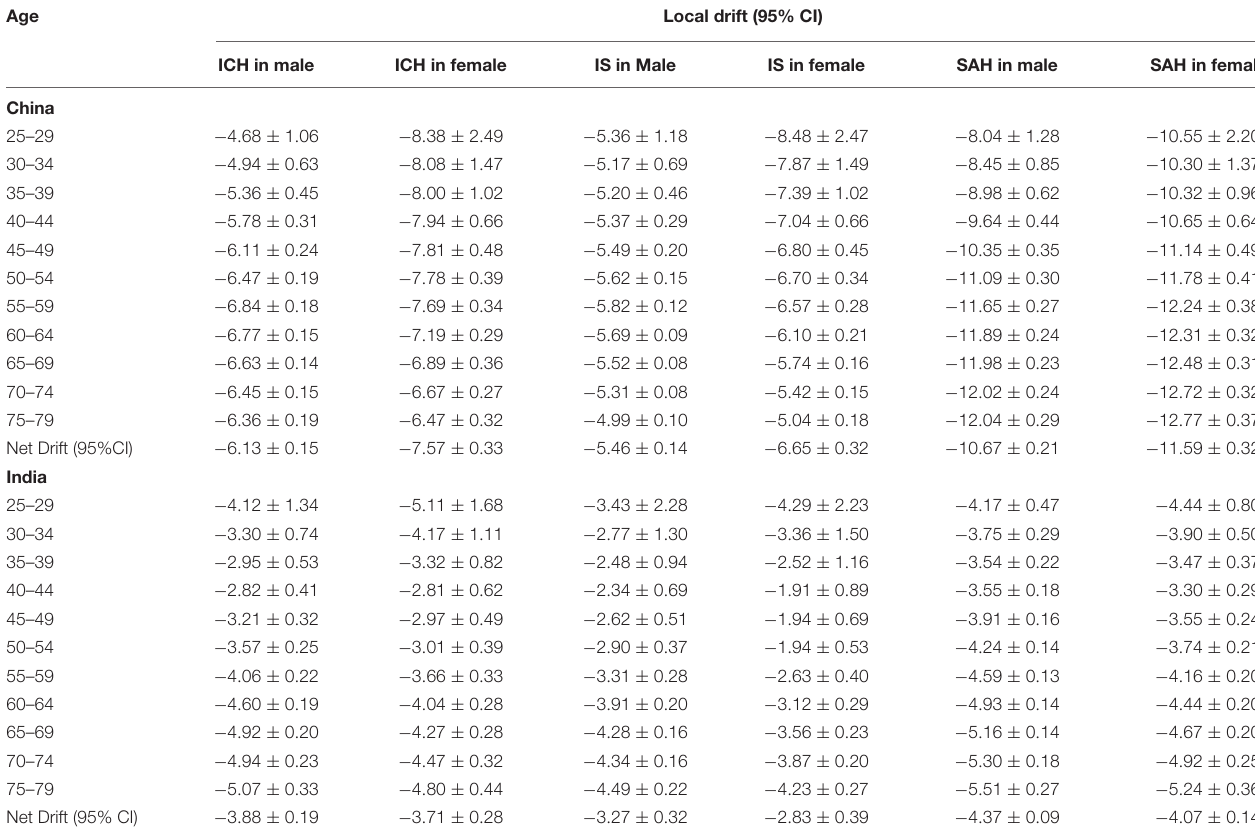
TABLE 1 | Local drifts and net drifts of household air pollution (HAP)-attributable subtype stroke for males and females in China and India. Age Local drift (95% CI) ICH in male ICH in female IS in Male IS in female SAH in male SAH in